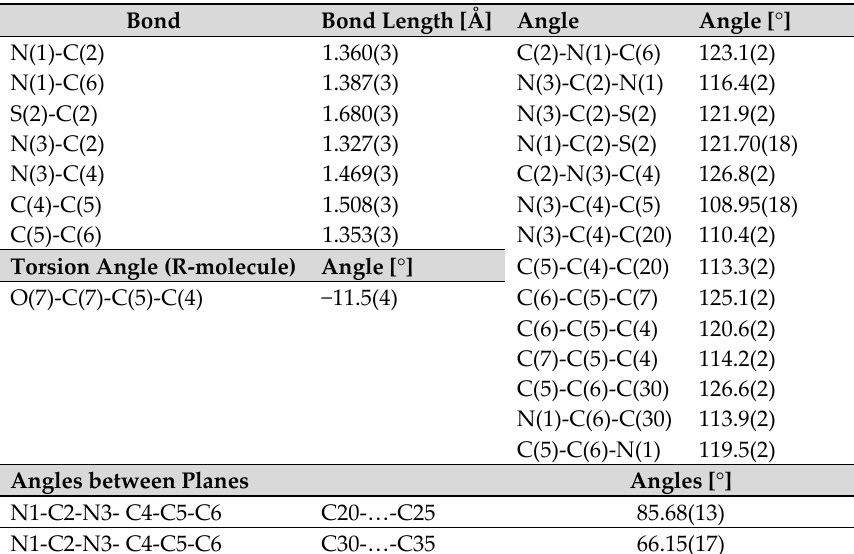
Table 3. Selected geometrical parameters for compound 4a.